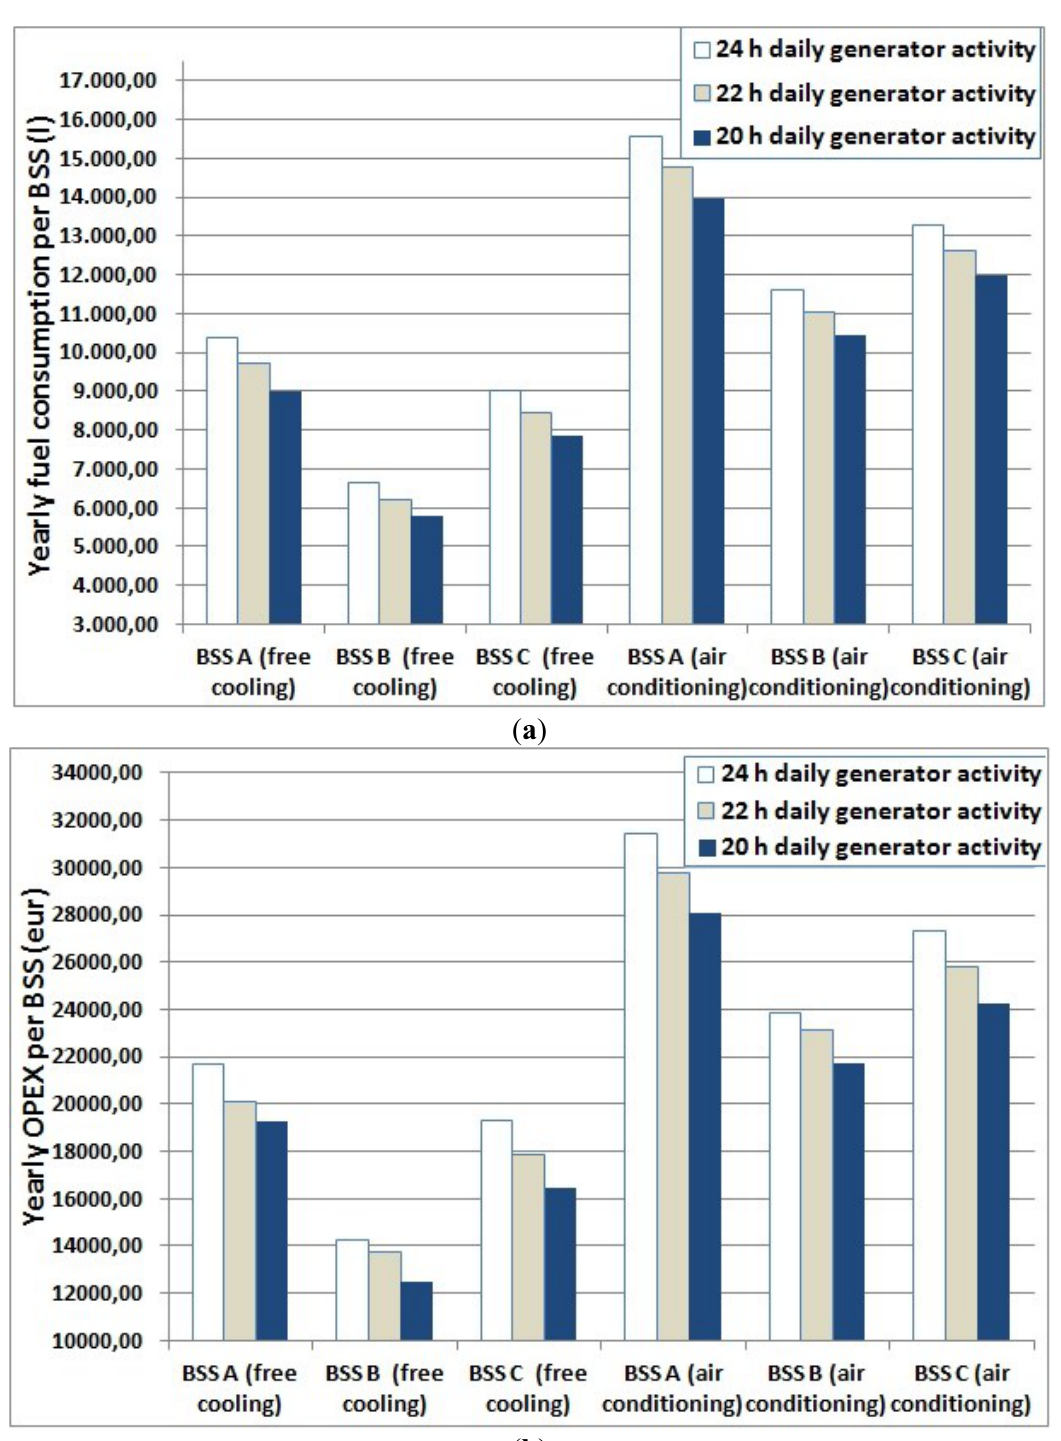
Figure 17. For different operating modes of power generators: ( a ) yearly fuel consumption per analyzed BSS; ( b ) yearly OPEX savings per analyzed